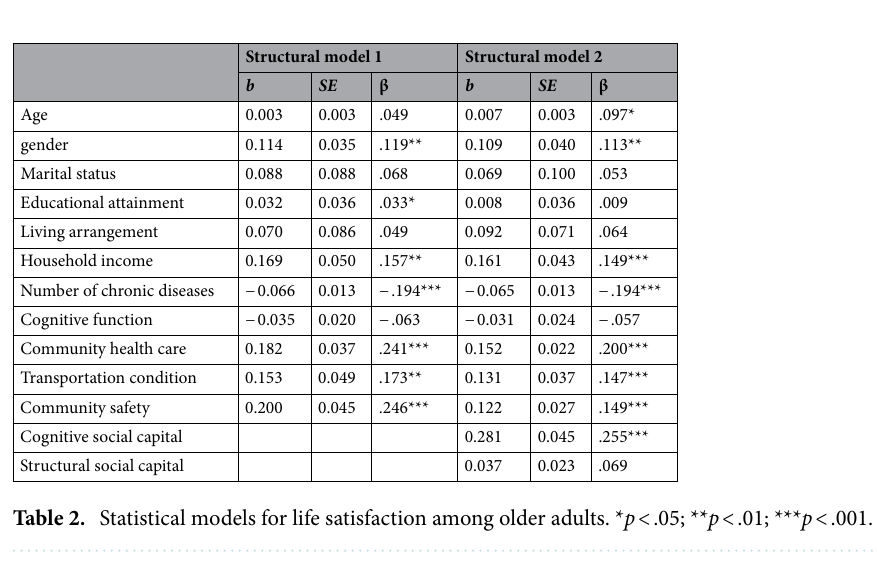
hood environment, cognitive social capital, and life satisfaction. Because the association of structural social capi-